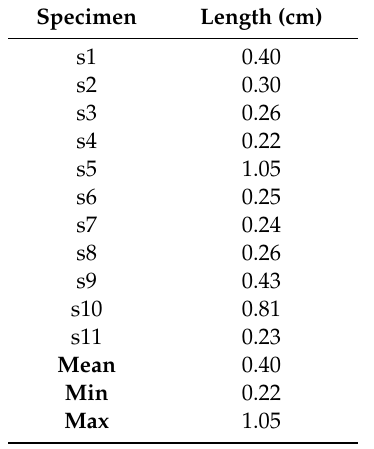
Table A2. Length measures of the stick-like structures from Vera Rubin Ridge, Mars. See Figure A2 for location of measurements.